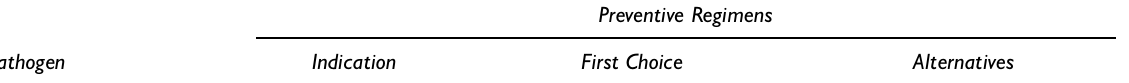
Table 13 Prophylaxis to prevent recurrence of opportunistic disease (ater chemotherapy for acute disease)